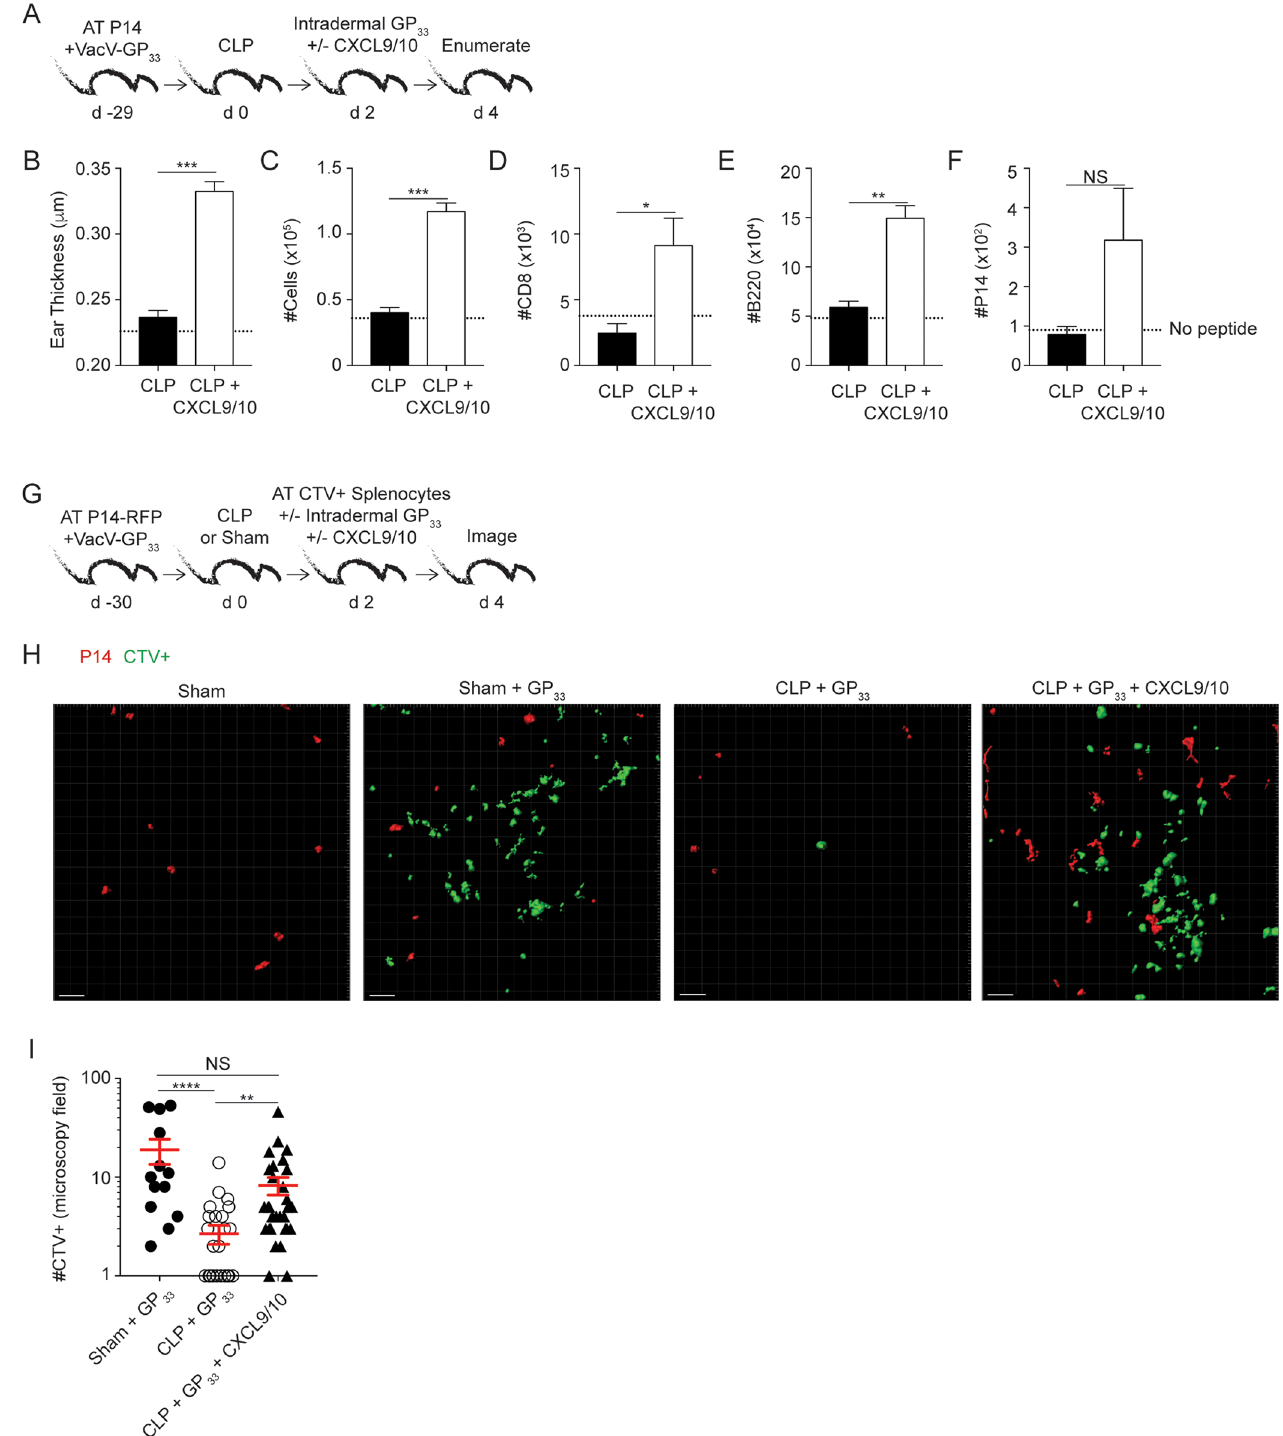
Fig 8. Exogenous CXCL9/10 administration at time of skin T RM activation improves effector cell recruitment in septic hosts. (A) Experimental design. Two days after CLP surgery left ears of VacV-GP 33 immune P14 chimeramice were treated in vivo with GP 33 peptidewith or without CXCL9/10treatment. (B) Thickness of left ear pinna after in vivo peptidestimulationwith or without CXCL9/10. Total numberof cells (C) or number of CD8+ CD45.2- (D), B220+ CD45.2- (E), and P14 CD45.2- (F) cells in the ear after skin T RM activationin the presenceor absenceof CXCL9/10. Dashed line represent number of cells in control CLP hosts that did not receive in vivo peptideinjection. (G) Experimental design. Two